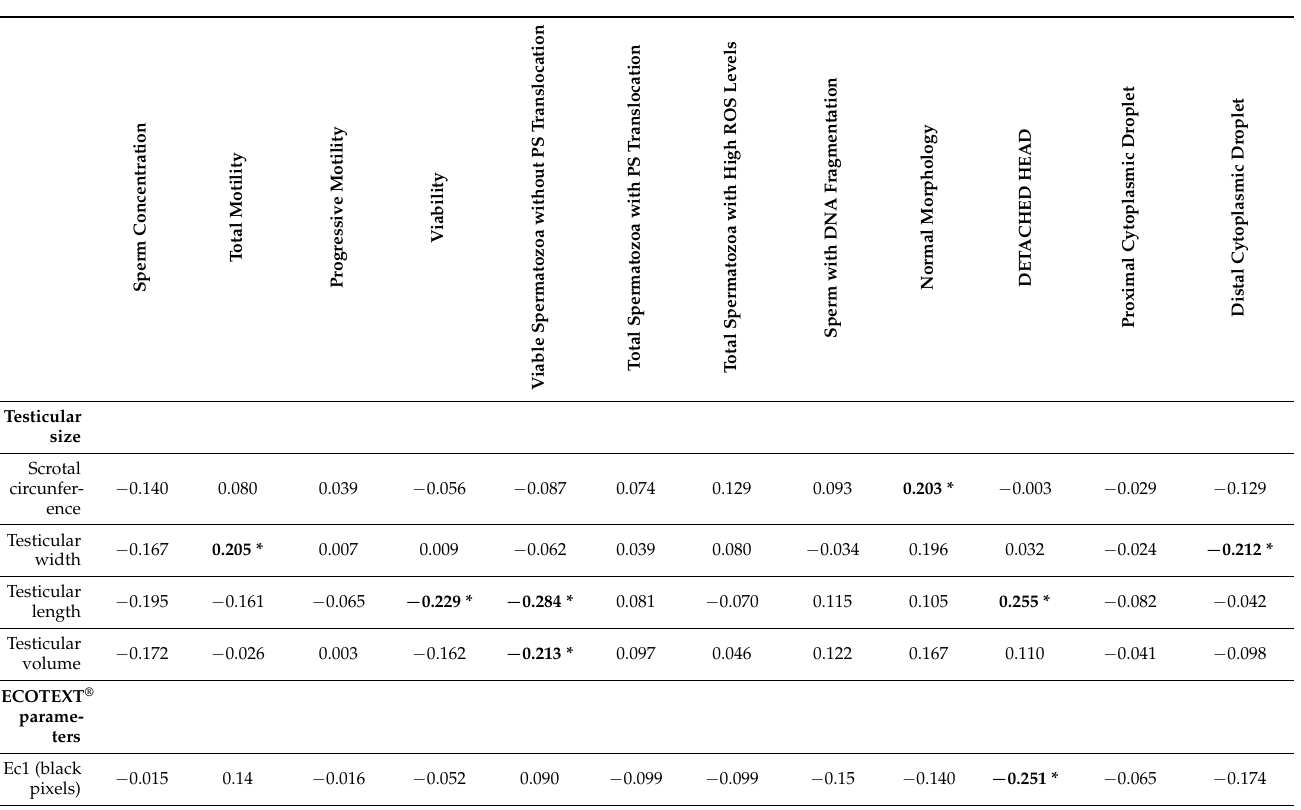
Table 4. Spearman’s rank correlation coefficient (Spearman’s ρ ) between testicular size, echotexture parameters (evaluated by ultrasound-video analysis and ECOTEXT ® software) or testicular-artery blood flow (assessed by color-Doppler flow imaging) and some sperm parameters, analyzed 30 days after the testes evaluation, in Rasa Aragonesa rams ( n = 96). Bold type indicates statistically significant correlations. * p < 0.05 and ** p <